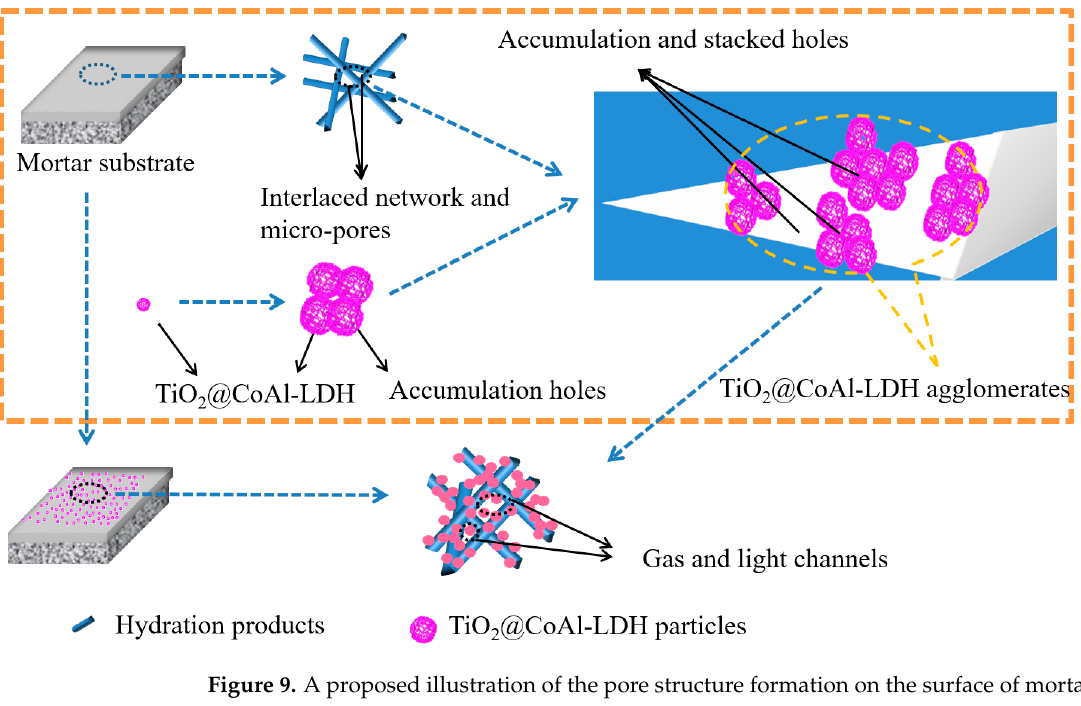
Figure 9. A proposed illustration of the pore structure formation on the surface of mortar prepared by smearing method.